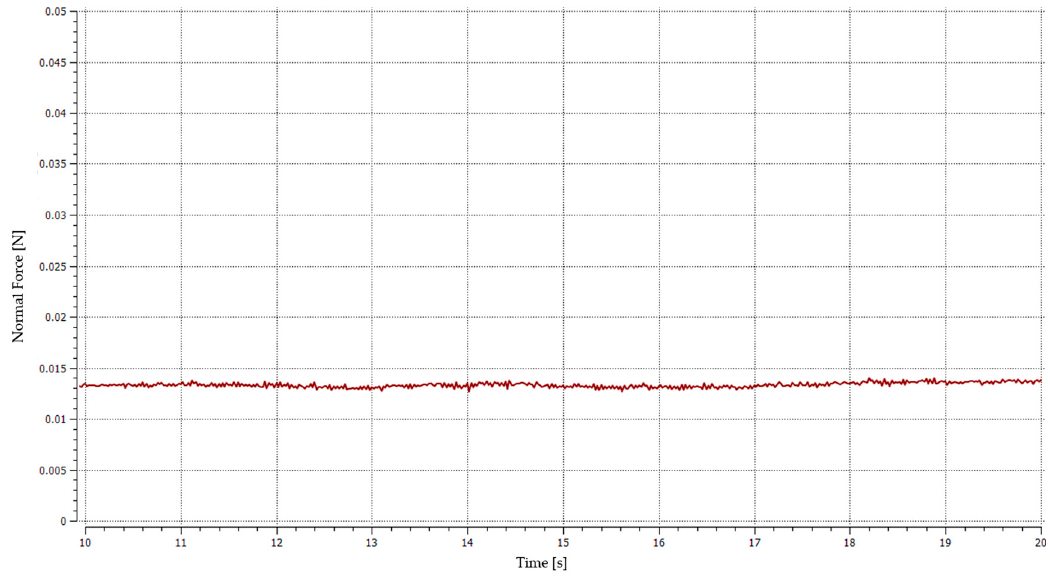
Figure 7. Average forces acting on the fruit in the normal directionreciprocating transport.